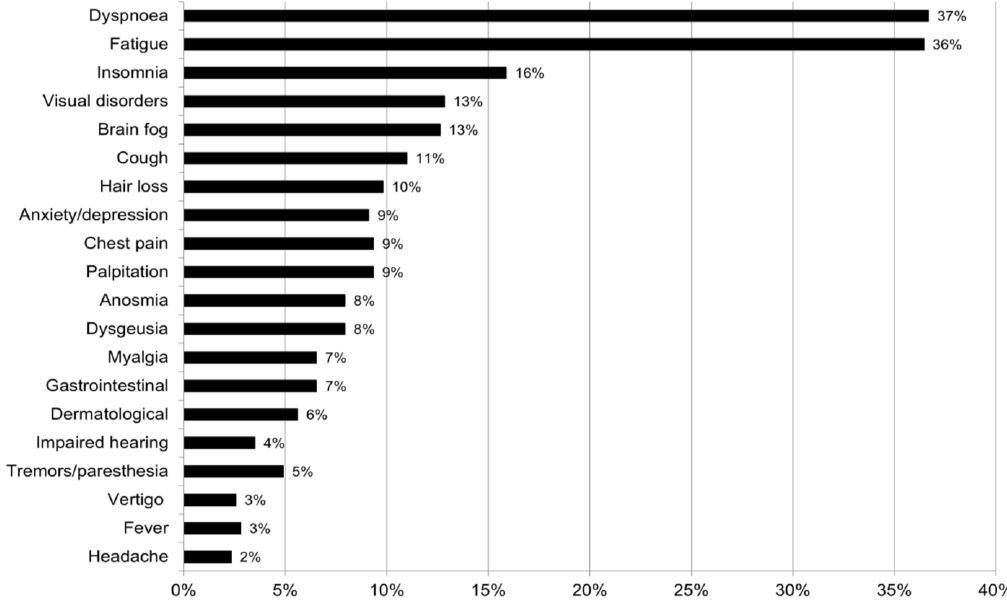
Figure 1. Prevalence of lingering symptoms in the study population (N = 428).